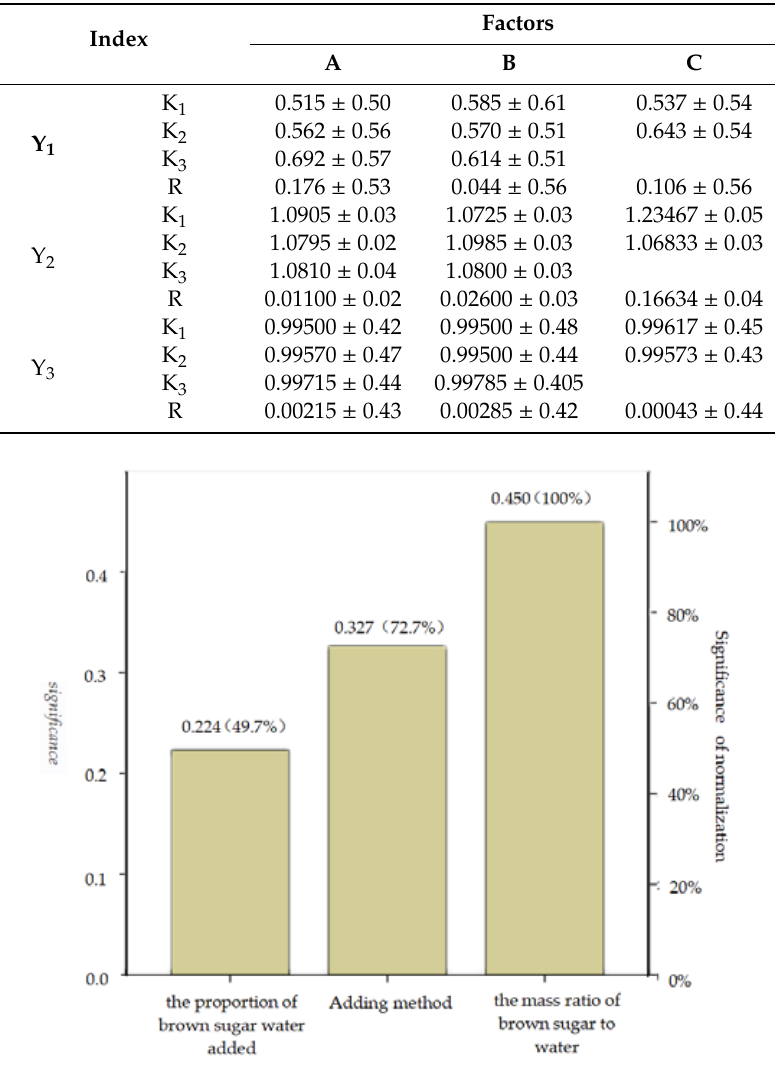
Figure 3. Chart of factor significance.